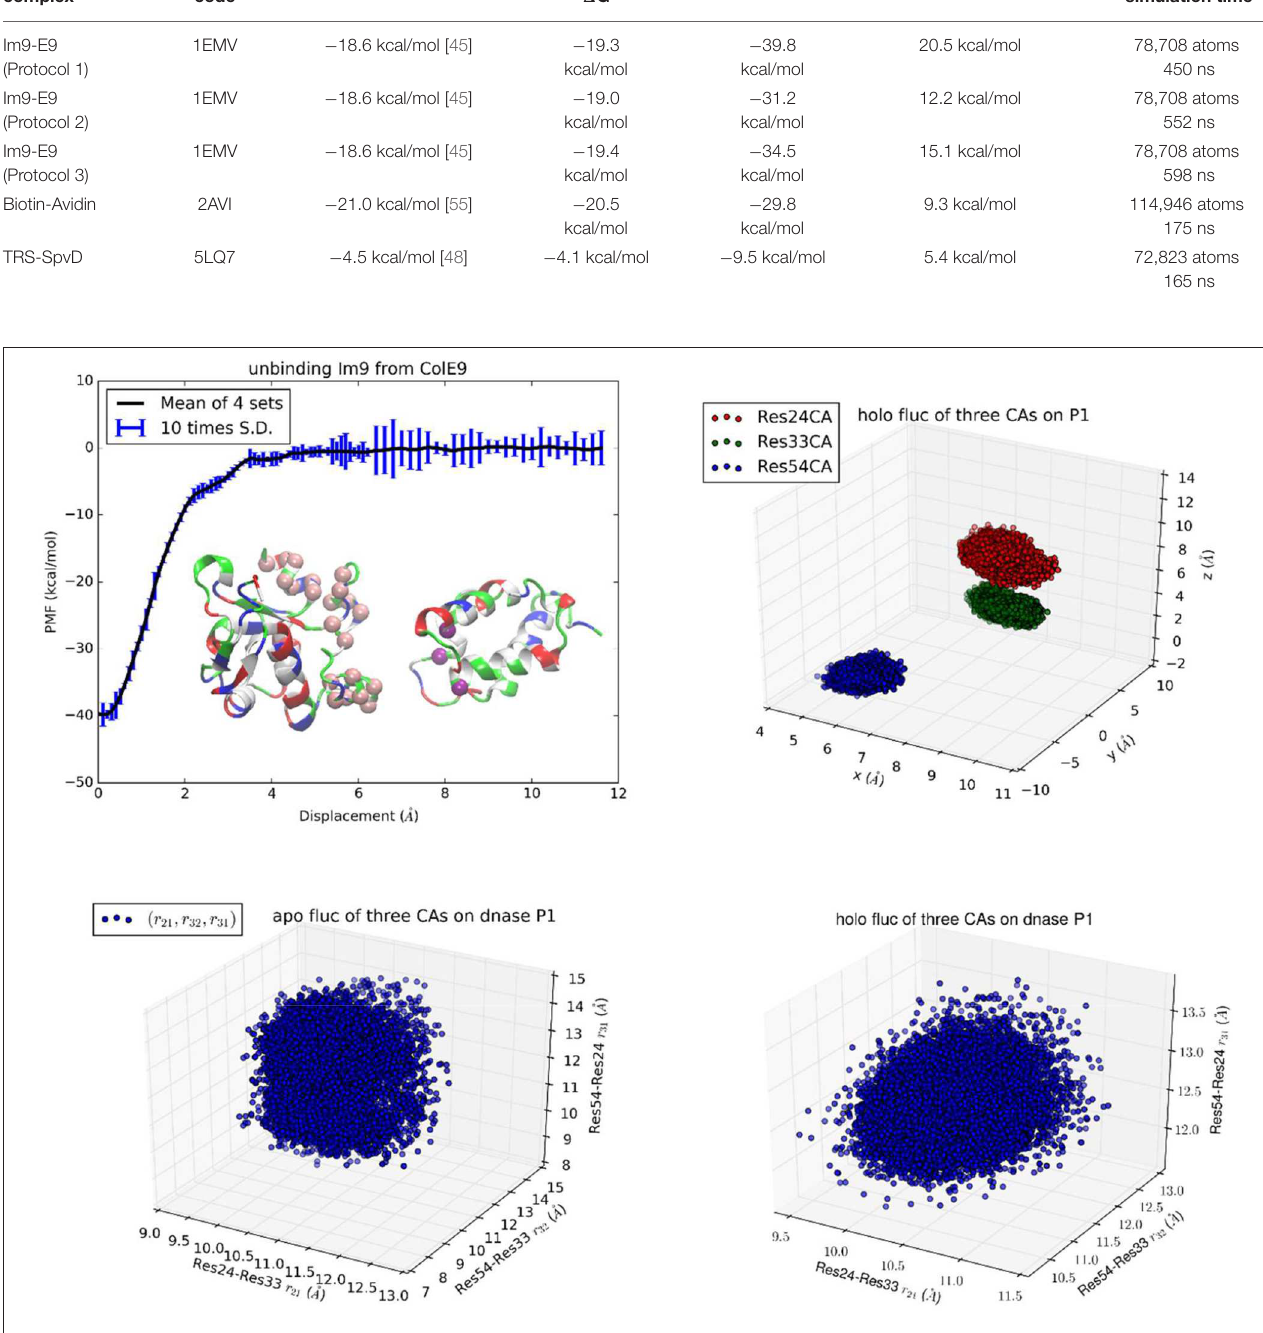
Frontiers in Physics |